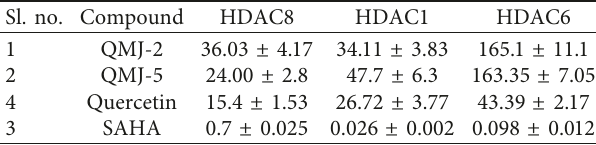
Table 3: Isoform-specific HDAC enzyme inhibition